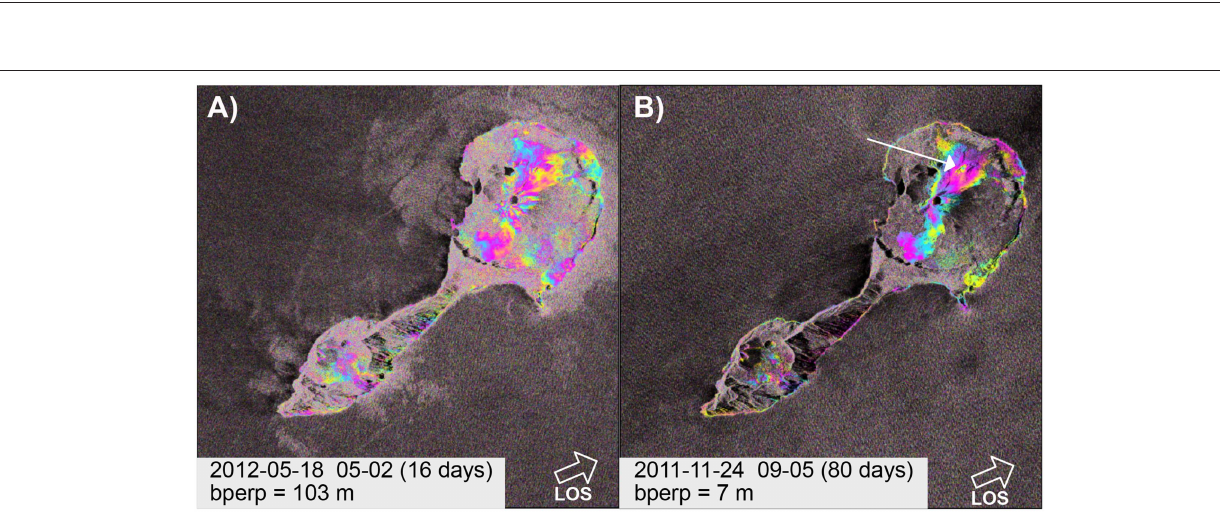
FIGURE 9 | Wrapped interferograms from ascending Cosmo-SkyMed X-band data. (A) Coherence is mostly maintained on lava flows and beaches even for short 16-day timespans. (B) Localized subsidence of northern scoria deposit as seen in ALOS and Envisat interferograms is pointed out by the white arrow. At X-band, the scoria compaction is only observed for timespans greater than 80